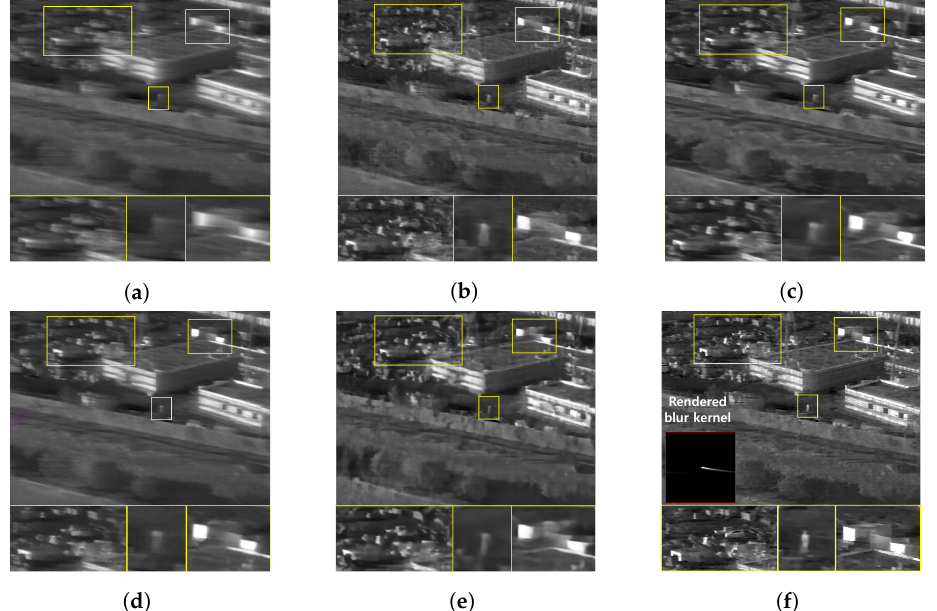
Figure 19. Qualitative comparison of motion deblurring results on the real blurry thermal image.